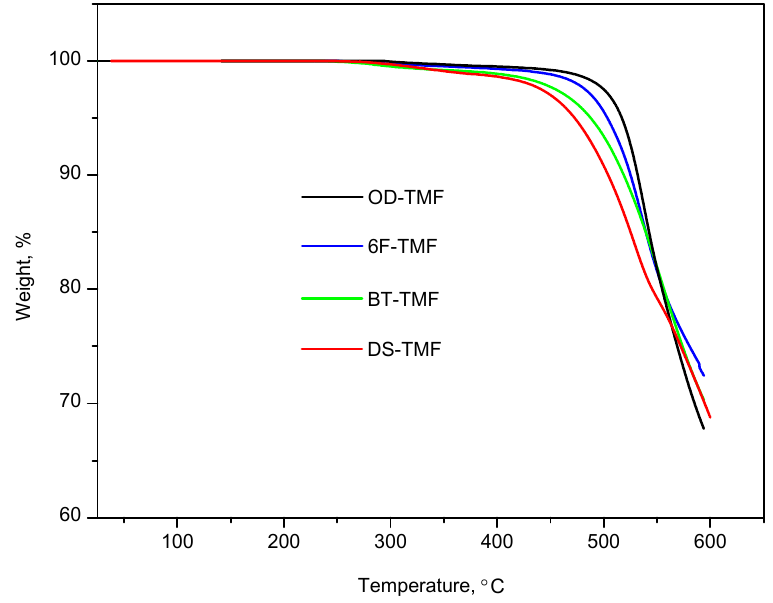
Figure 3. TGA curves measured under N 2 atmosphere for the TMF-based polyimides reported in this